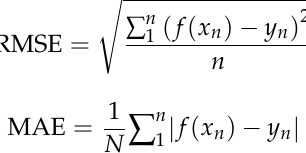
Table 3. Overall, for the test period in 2020, the neural network models (ED-FCNN, LSTM, TCN and FLT) and the DA reduce the average RMSE (MAE) by 43.27% to 52.36% (42.00% to 51.50%) and increase the average ATF by 34.12% to 43.12% compared with the ECMWF-IFS model output. Among them, only neural network models decreased the average RMSE (MAE) by 48.00% to 52.36% (46.50% to 51.50%) and improved the average ATFs by